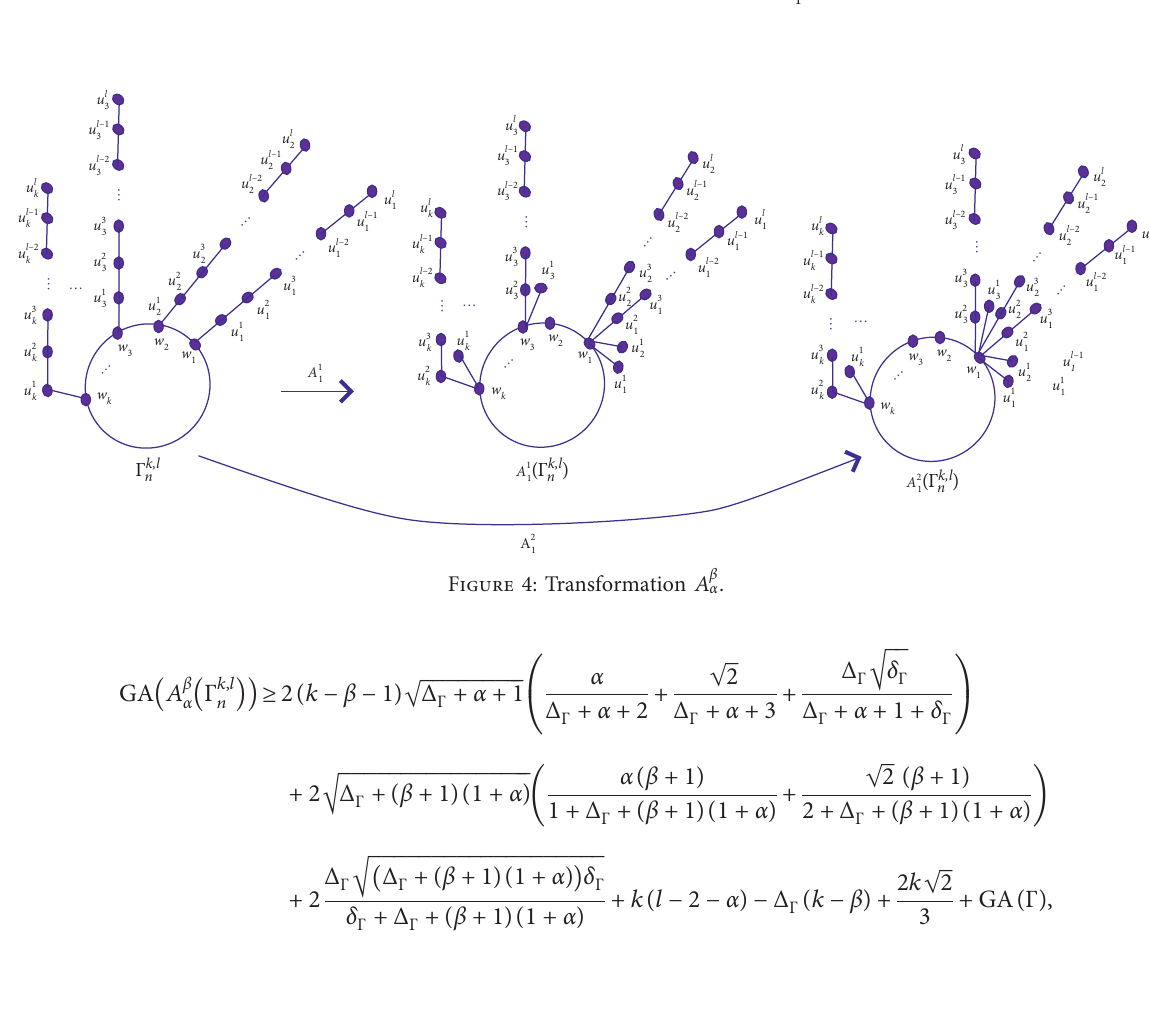
Figure 3: Transformation B for fixed vertex w